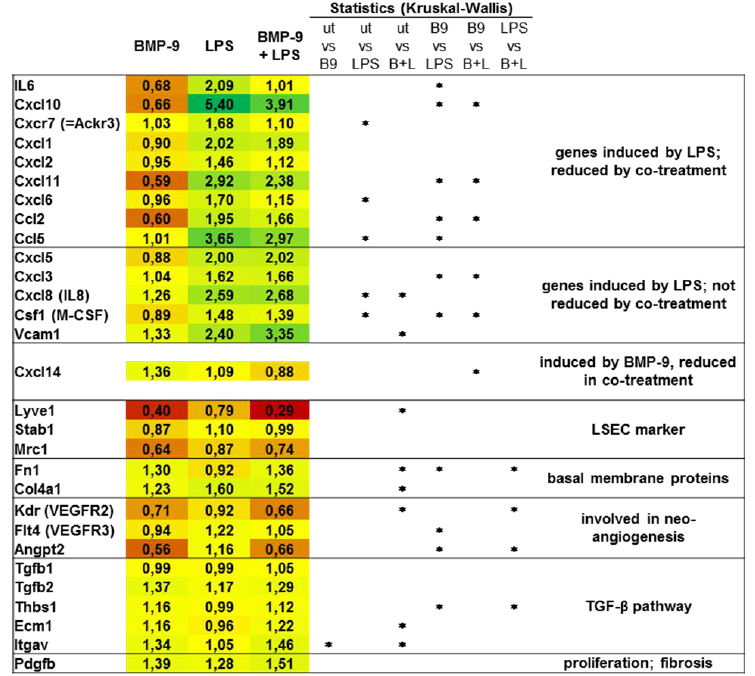
Figure 4. Affymetrix array analysis of BMP-9/LPS responses in human LSEC. Human LSEC were stimulated with BMP-9 and LPS as in Figure 3 and RNA samples from 3 independent experiments were subjected to Affymetrix array analysis. Data for selected targets are presented as average expressions expressed as “fold of untreated”. Red colour indicates down-regulated expression and green upregulation. Bright yellow was set as 1 (= unchanged expression compared to untreated). p < 0.05 was considered statistically significant (*)